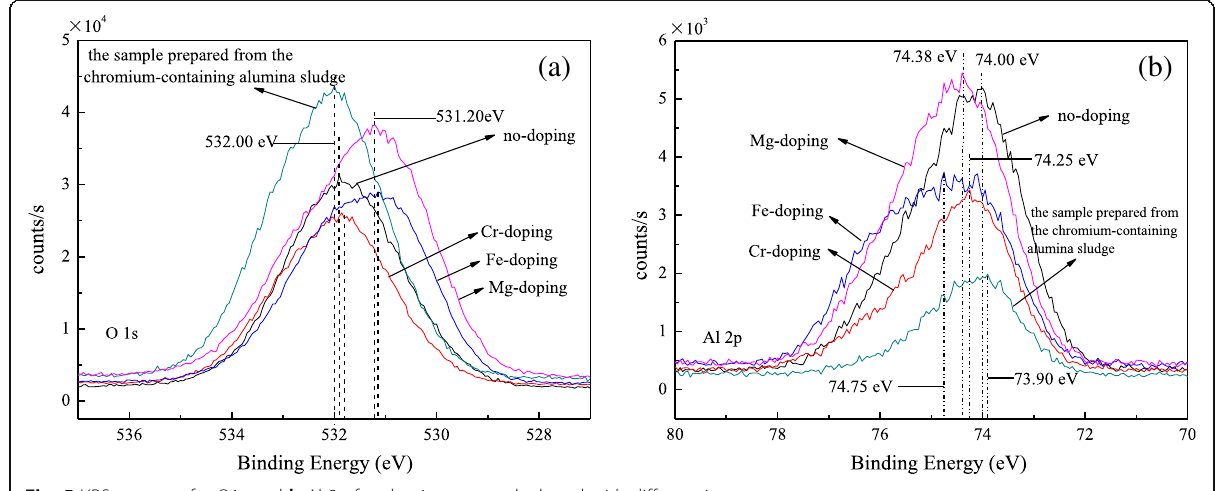
Fig. 5 XPS spectra of a O1 s and b Al 2 p for alumina nanorods doped with different ions